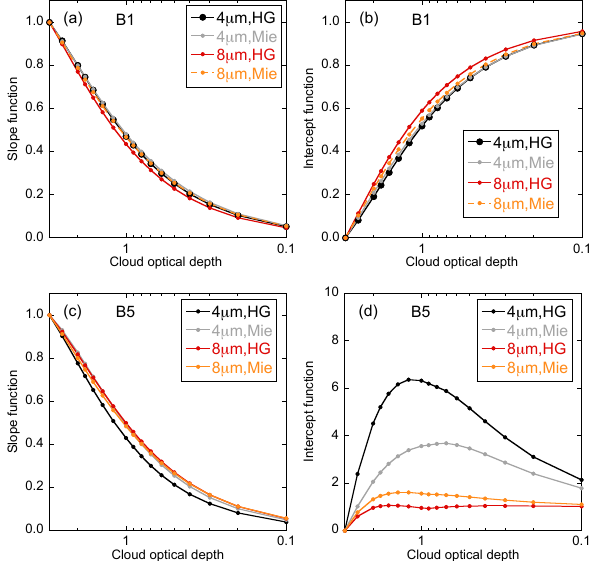
Figure 7. (a) Slope and (b) intercept functions derived from band B1 (400–870 nm wavelengths). 3 Fig. 7. (a) Slope and (b) intercept functions derived from band B1 (c) and (d) are the same as (a) and (b), but derived from band B5 (2110–2220 nm wavelengths). 4 (400–870nm wavelengths). (c) and (d) are the same as (a) and (b), Each plot shows results for two cloud drop sizes (4 and 8 µm) and two types of phase functions 5 but derived from band B5 (2110–2220nm wavelengths). Each plot (Henyey-Greenstein and Mie). 6 shows results for two cloud drop sizes (4 and 8µm) and two types of phase functions (Henyey-Greenstein and Mie).